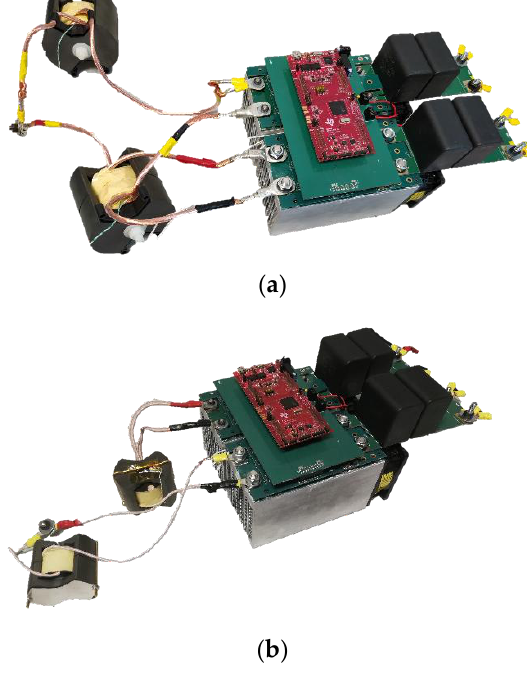
Figure 12. Experimental prototype. ( a ) DAB-FPP; ( b ) DAB-PPP.